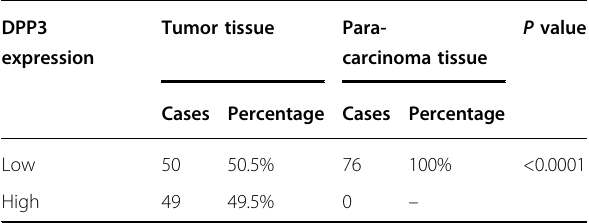
Table 2 Relationship between DPP3 expression and tumor characteristics in patients with colorectal